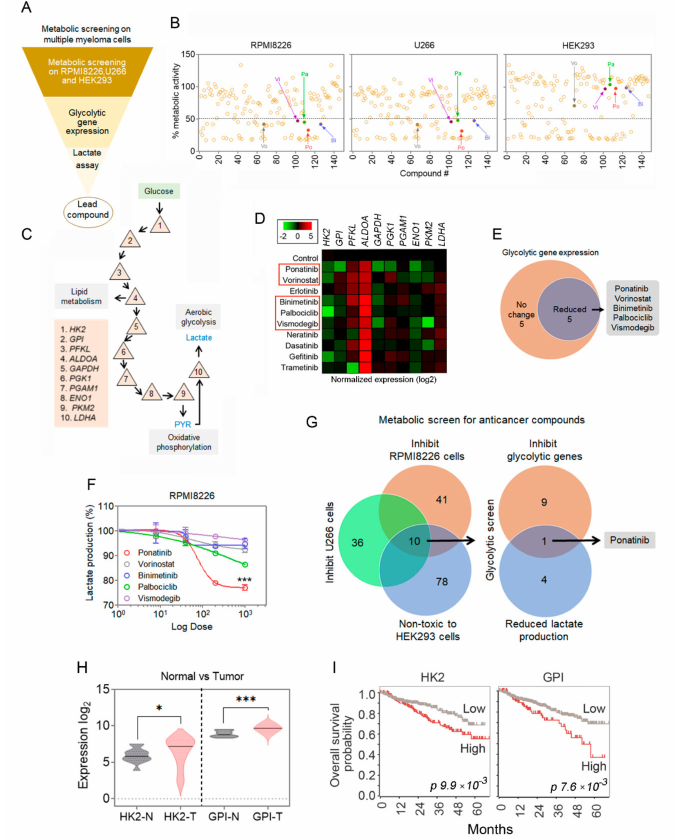
Figure 1. Metabolic screen of multiple myeloma cells. ( A ) Schematic for metabolic screening targeting glycolysis pathway in MM cells. ( B ) Assay for metabolic efficiency of compounds from NCI-drug library on RPMI8226 and U266 MM cells; HEK293 cells were used to determine the toxicity of the compounds. Each point represents a single compound from the library; the assay was performed in duplicate for reproducibility (Vo = vorinostat, Vi = vismodegib, Pa = palbociclib, Po = pona- tinib, Bi = binimetinib). Cells were incubated with the drug compounds for 72 h for the assay. ( C ) Schematic diagram of the glycolysis pathway for the enzymatic links. ( D , E ) The top ten selected drug candidates were screened for inhibition of glycolytic genes by qPCR. The drug treatment was for 12 h on RPMI8226 cells. ( F ) The top 5 candidates were further screened for inhibition in lactate production using a lactate assay kit on RPMI8226 cells; drug treatment was for 24 h. Data are presented as mean ± SEM; t -test: *** p < 0.001. ( G ) Venn diagram shows ponatinib was the best candidate compound for glycolysis gene and lactate production inhibition. ( H ) HK2 and GPI signals were analyzed in normal and MM cells in cancer patients. The patient data were obtained from the R2 platform (hgserver1.amc.nl) (GEO ID: GSE2658). N = normal tissue; T = tumor. Data are plotted as mean with the shaded distributions; * p < 0.05, *** p < 0.001, provided by R2 platform search engine (via one-way ANOVA on ranks). ( I ) Kaplan–Meier overall survival plots of MM patients with respect to HK2 and GPI RNA message levels are shown. Significance p-values are indicated in the figure, provided by R2 platform search engine (hgserver1.amc.nl) (GEO ID: GSE2658) (via one-way ANOVA on